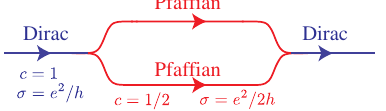
FIG. 15. Gluing and splitting a pair of chiral Pfaffian 1D channels into and from a chiral Dirac